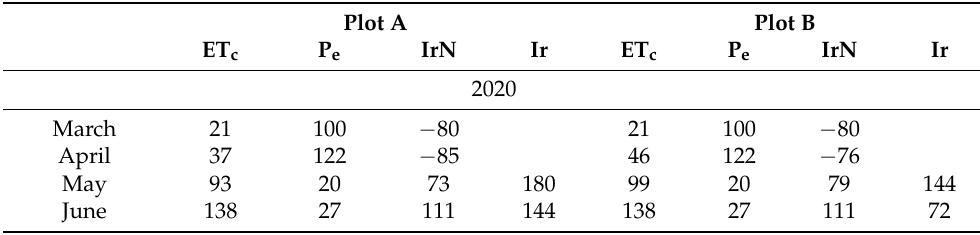
Table 7. Monthly kiwi Evapotranspiration (ET c ) in mm, Effective Precipitation (P e ) in mm, Irrigation water Needs (IrN) in mm (IrN = ET c − P e ), and Irrigation water applied (Ir) in mm, for plots A and B during the 2020 and 2021 growing